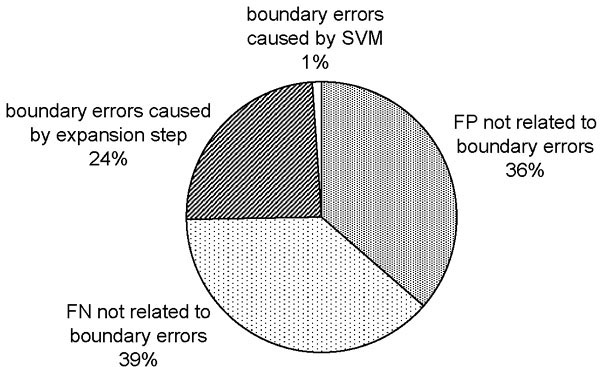
Error analysis. Proportions of different causes for four classes of errors. We distinguish between boundary errors and non-boundary errors (see text).